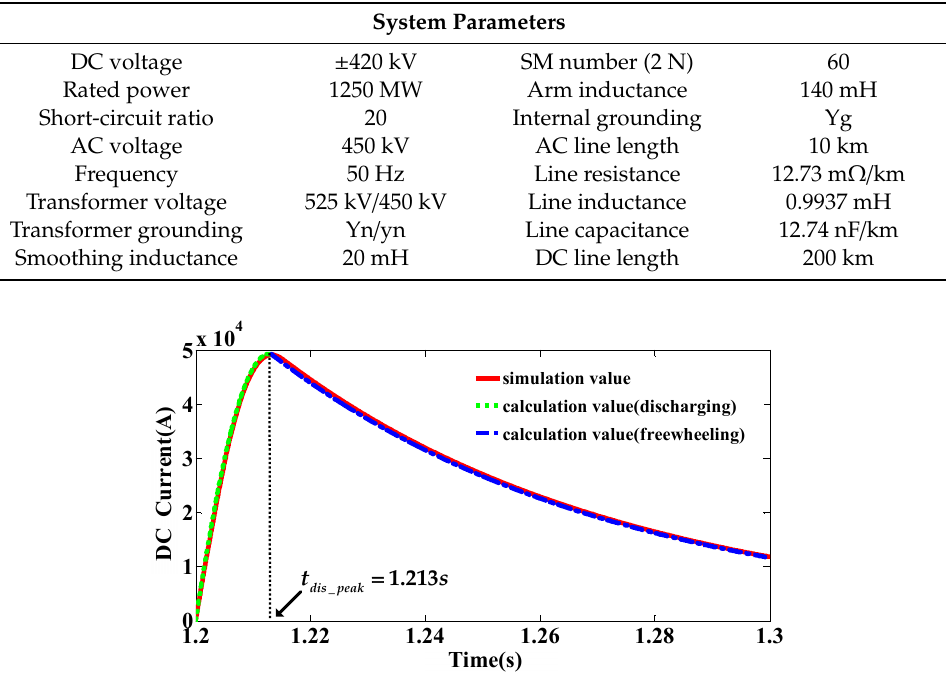
Figure 8. Simulation and calculation values of the DC line current.